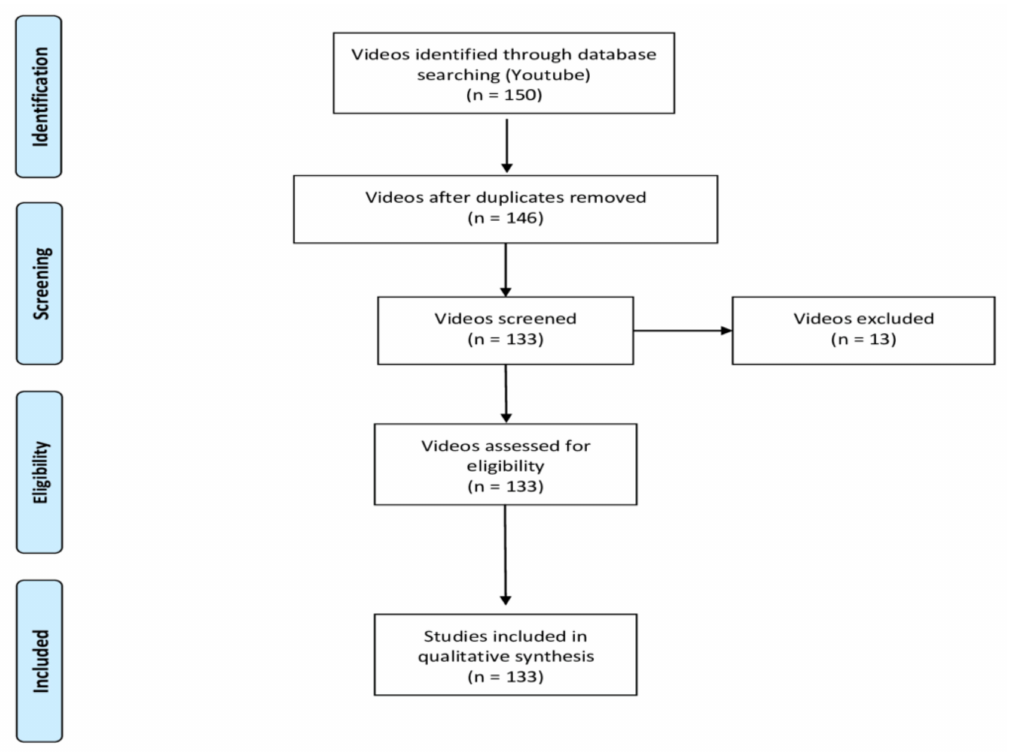
Figure 1. Video flow diagram